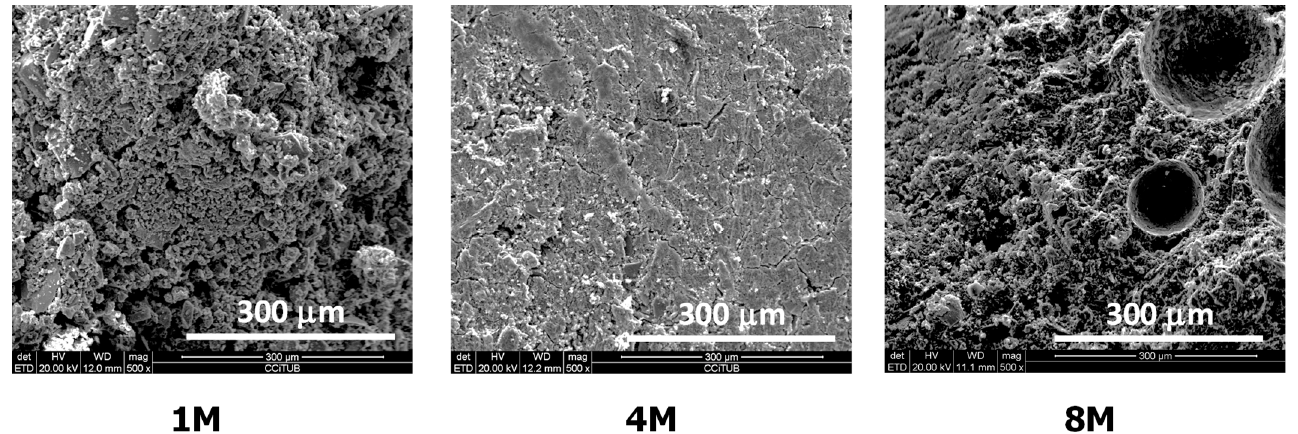
Figure 8. SEM micrographs of the AAC formulations with an L/S ratio of 0.5 (i.e., 1 M = 05LS1M, 4 M = 05LS4M, 8 M = 05LS8M).